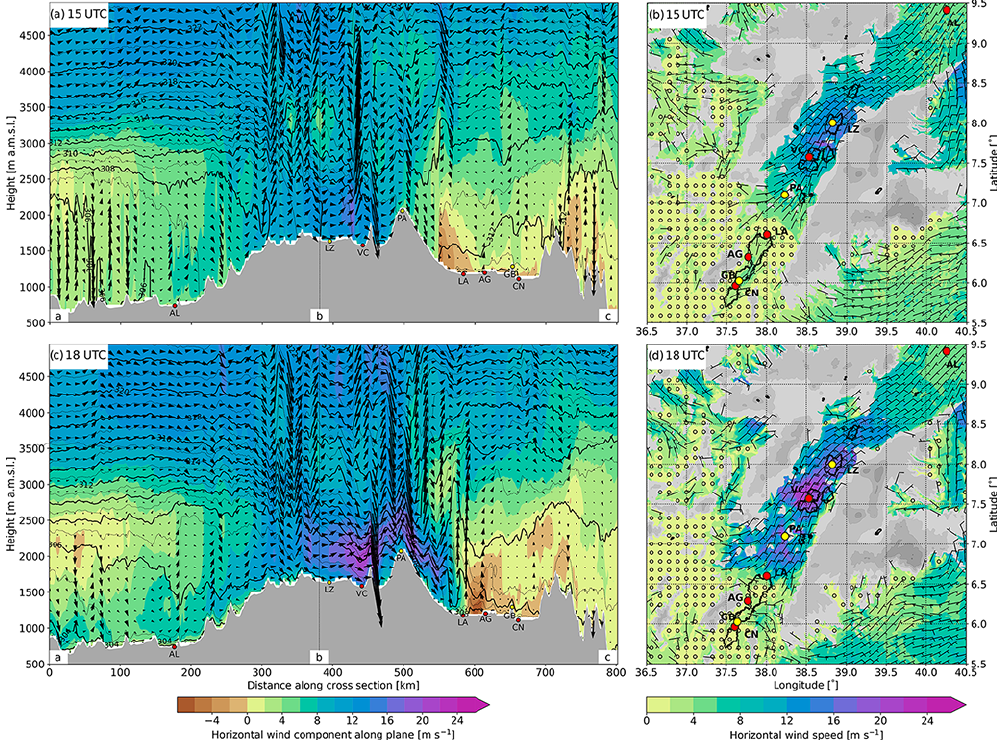
Figure 5. WRF simulation (domain d02) of the north-eastern gap flow on 14 January 2020 at (a) – (b) 15:00UTC and (c) – (d) 18:00UTC: (a, c) vertical transect along line a–b–c (see Fig. 1b) through the GRV from the Afar Triangle (left) to the Turkana Channel (right) showing the potential temperature (black contour lines, 1K increments), the horizontal wind component along the transect (colour contours, 2ms − 1 increments), and arrows for the 2D wind field on the vertical plane. (b, d) Wind field at 2000ma.m.s.l. with the horizontal wind speed (colour contours, 2ms − 1 increments) and wind barbs (half barb for 5ms − 1 and full barb for 10ms − 1 ). Grey shading represents the topography. In (c) and (d) only the terrain exceeding 2000ma.m.s.l. is shown. The bend of the transect at point b is marked in (a) and (c) by a vertical dashed line. Black lines in (b) and (d) indicate lakes resolved by the model. The following locations are marked: Aledeghi (AL), Lake Ziway (LZ), the along-valley centre (VC), the pass (PA), the northern end of Lake Abaya (LA), AWS Alge (AG), God’s Bridge (GB), and the AWS Chamo North